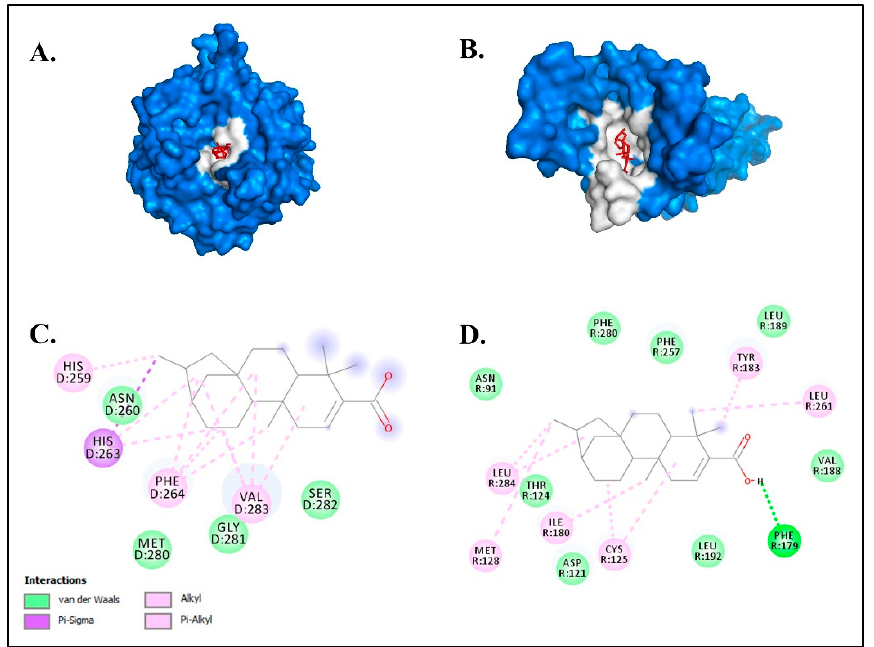
Figure 4. The molecular docking results of kaurenoic acid against the melanogenesis-related pro- teins ( A ) TYR and ( B ) MC1R. The chemical bond ligand–protein interaction of kaurenoic acid with ( C ) TYR and ( D ) MC1R.